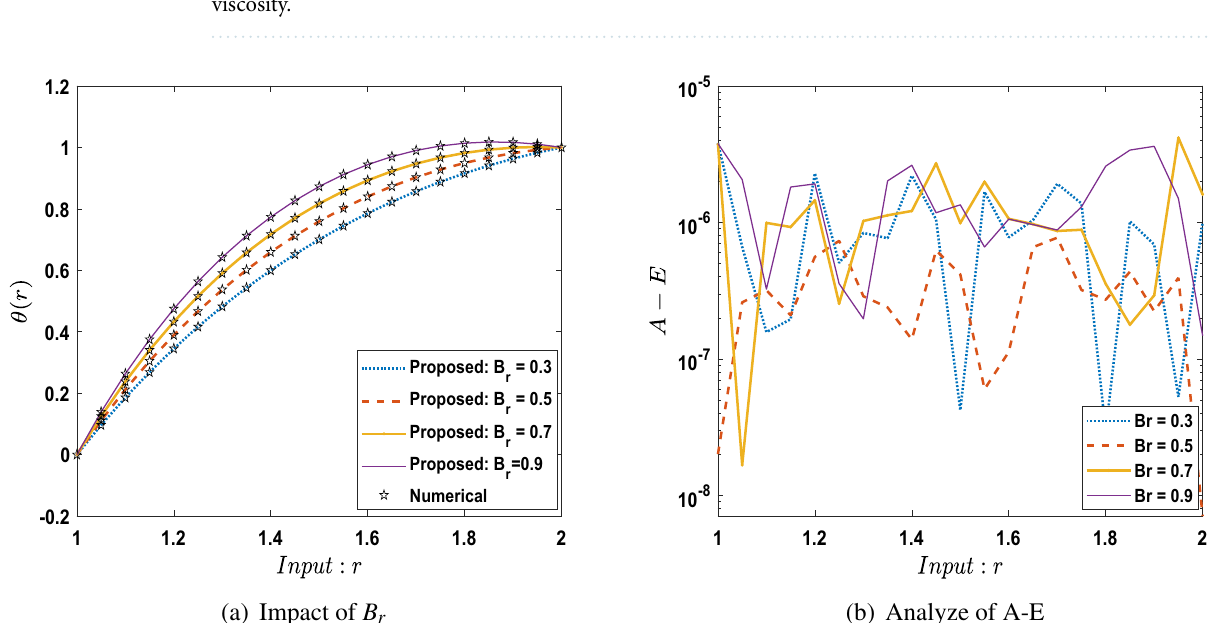
Figure 25. Comparison between suggested LMA-TNN with results of numerical reference for scenario 1 in Vogel’s